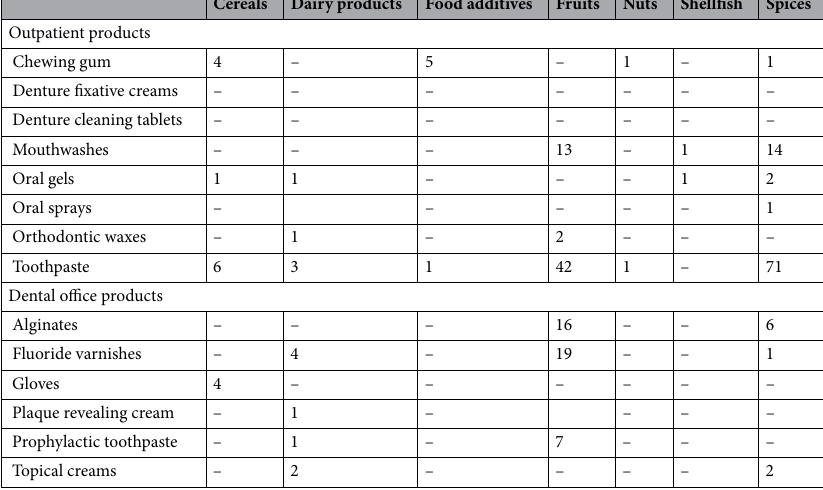
Cereals Dairy products Food additives Fruits Nuts Shellfish